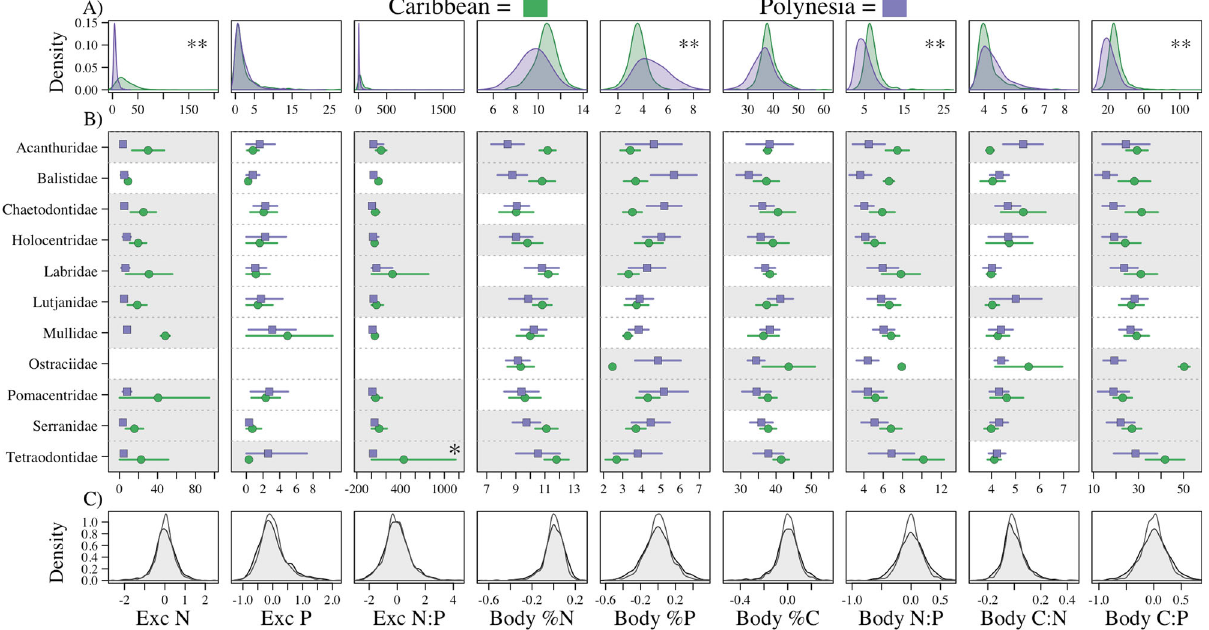
Fig. 3 Absolute differences in the chemical traits of species that belong to the same family, but live in different regions, are explained by phylogenetic differences, alone. A Distribution plots of raw data across the Caribbean (green) and Polynesia (purple) for each chemical trait (labels on x -axis of panel C ). “ ** ” indicates statistical signi fi cance as determined from the global model in Question 1 ( n = 1266, 1133, 1123, 1255, 1255, 1255, 1255, 1255, and 1255 individuals, respective to the traits labeled in C ). B Absolute means (symbols) and standard deviations (lines) from raw data of chemical traits for each of the twelve families that are represented in both regions. Chemical trait data points for each family pair with shaded gray backgrounds indicate absolute trait differences quanti fi ed by ANOVA. Values associated with “ * ” indicate trait differences that are beyond what would be predicted by evolutionary history. Empty spaces for Ostraciidae are due to missing data for this family for these traits. C Distributions of the residual error from each model (ANOVA = gray, Phylogenetic model = white) for each